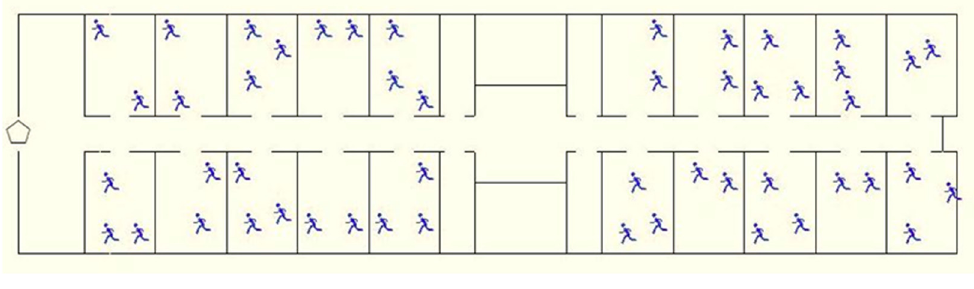
Figure 5. Distribution of personnel in Yibei building.